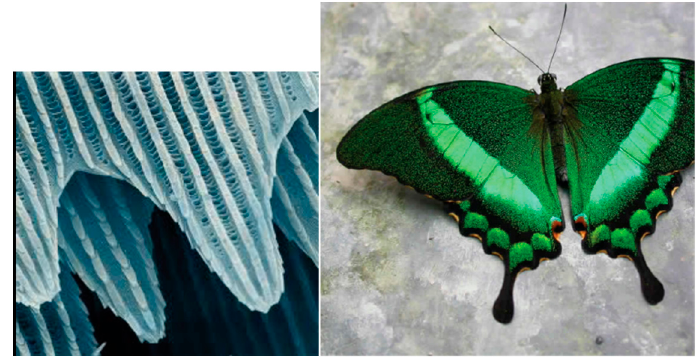
Figure 4. Structure organization of chitin in a butterfly wing.